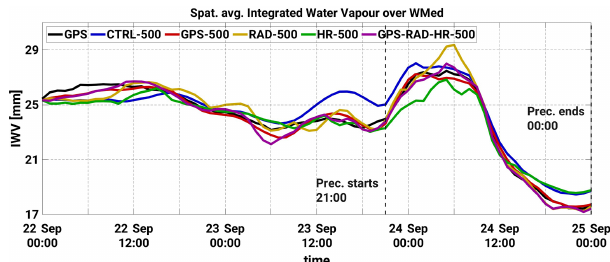
Figure 7. Temporal evolution of spatially averaged IWV for the simulations with the 500m grid. IWV is obtained through interpola- tion to the location of the GPS stations, applying a height correction following Bock and Parracho (2019). The corresponding results for the 7 and 2.8km simulations can be found in Figs. S3b and S4b of the